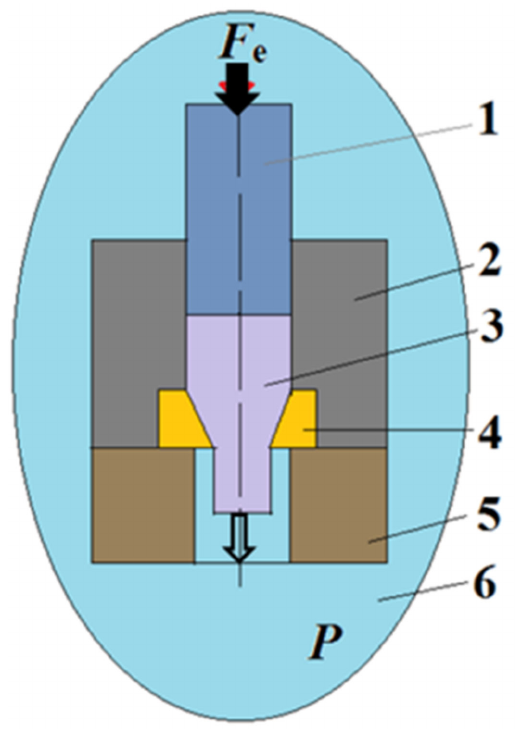
Figure 2. Schema of Hot Extrusion; 1—plunger. 2—container. 3—deformable thermoelectric material. 4—die. 5—support washer. 6—working fluid. P —working fluid pressure. F e —extrusion